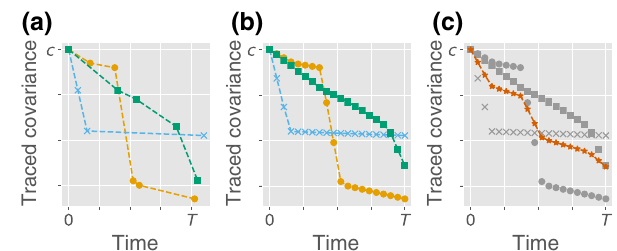
FIG. 4. Illustration of Bayes risk calculation for time-limited environments. (a) Three time series, each of which corresponds to one episode (i.e., one Bayesian estimation): the “zeroth” data point at time 0 corresponds to the uncertainty c in the prior [see Eq. (B9)], and the k th data point in each time series corresponds to the k th experiment of that episode; its x coordinate is the accumulated time used for the first k experiments, and its y coor- (cid:4) (cid:3) ( θ ) . The time limit is dinate is the traced covariance tr cov θ | D k T , which is overstepped only with the last experiment of each episode. Linear interpolation of each time series (dashed lines) and evaluation of the linear interpolants at equally spaced times spanning [0, T ] yields (b), depicted with 20 equally spaced times. Then, we can take a timewise mean of the data (i.e., for each of the 20 equally spaces times, we calculate the mean over all time series). This gives us the mean of the interpolated traced covari- ance [depicted as red stars in (c)], which serves as an approximate time-resolved Bayes